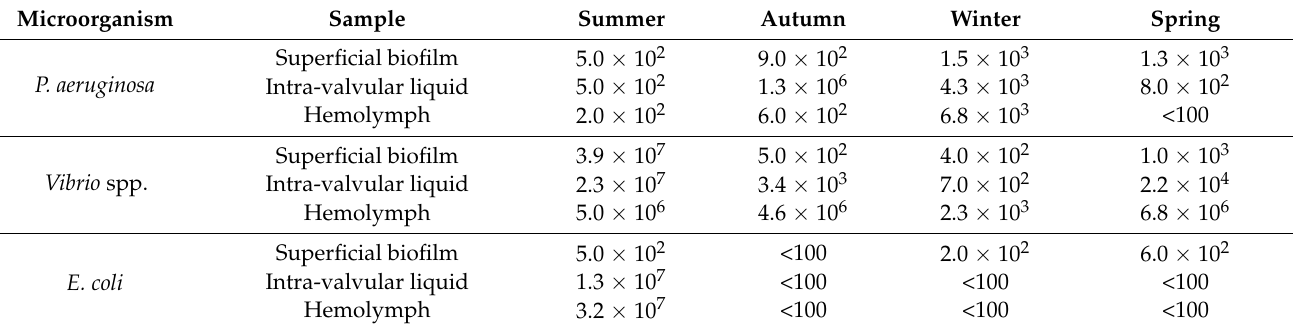
Table 3. Bacterial quantification using the FISH method on superficial biofilm, intra-valvular liquid, and hemolymph in four seasonal sampling